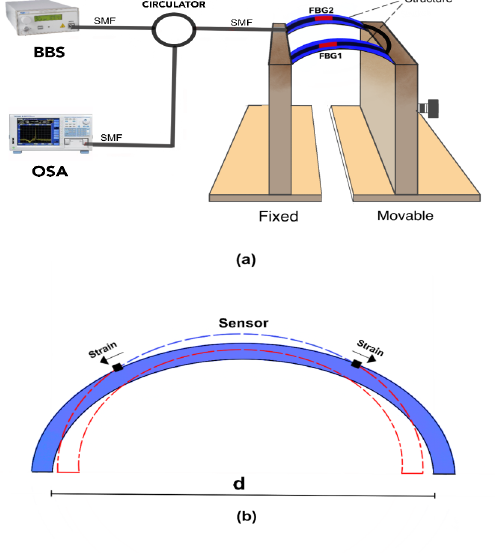
Figure 1. (a) Schematic of the experimental setup. (b) Mecha- nism of operation of the structure that demonstrates the diame- ter reduction using the proposed structure developed with a 3D Printer.